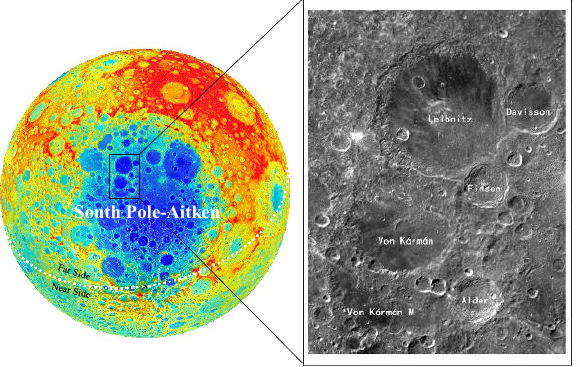
Figure 1. Context maps of CE-4 landing site. Left: LOLA DEM centered in the middle of the SPA basin, Right: Chang’e-2 DOM.